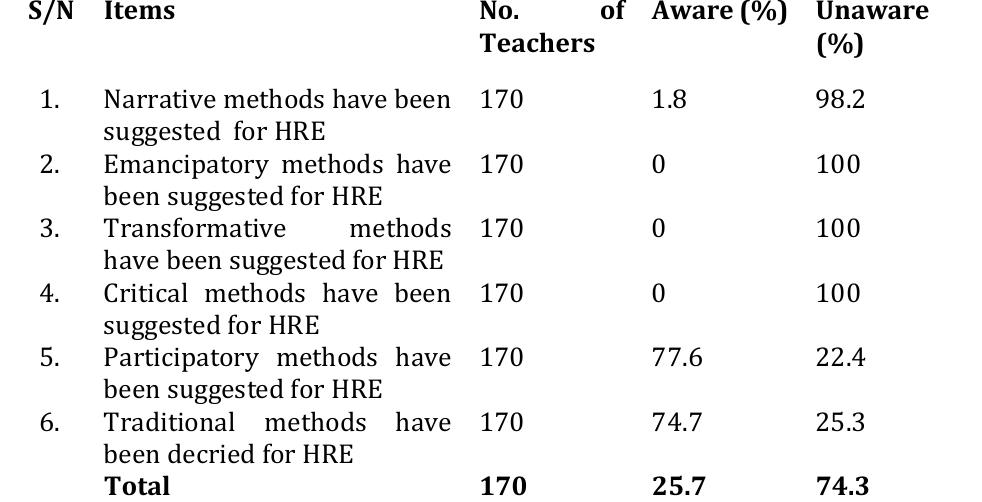
Table 3: Percentage representation of teachers’ awareness of human rights education pedagogical